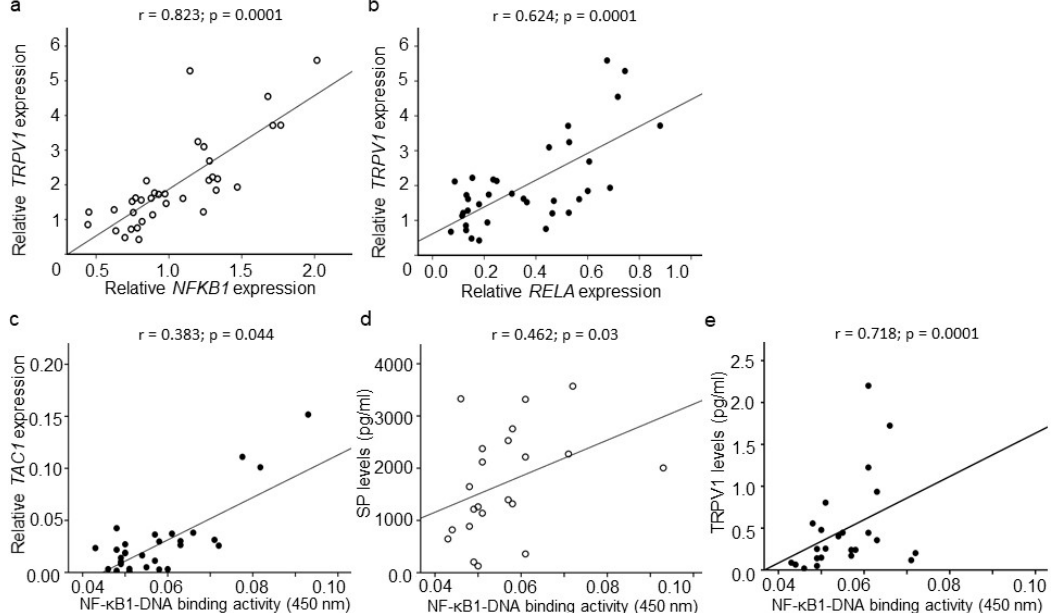
Figure 5. Relationship among NF- κ B, SP and TRPV1 expression in DDD patients. Correlations